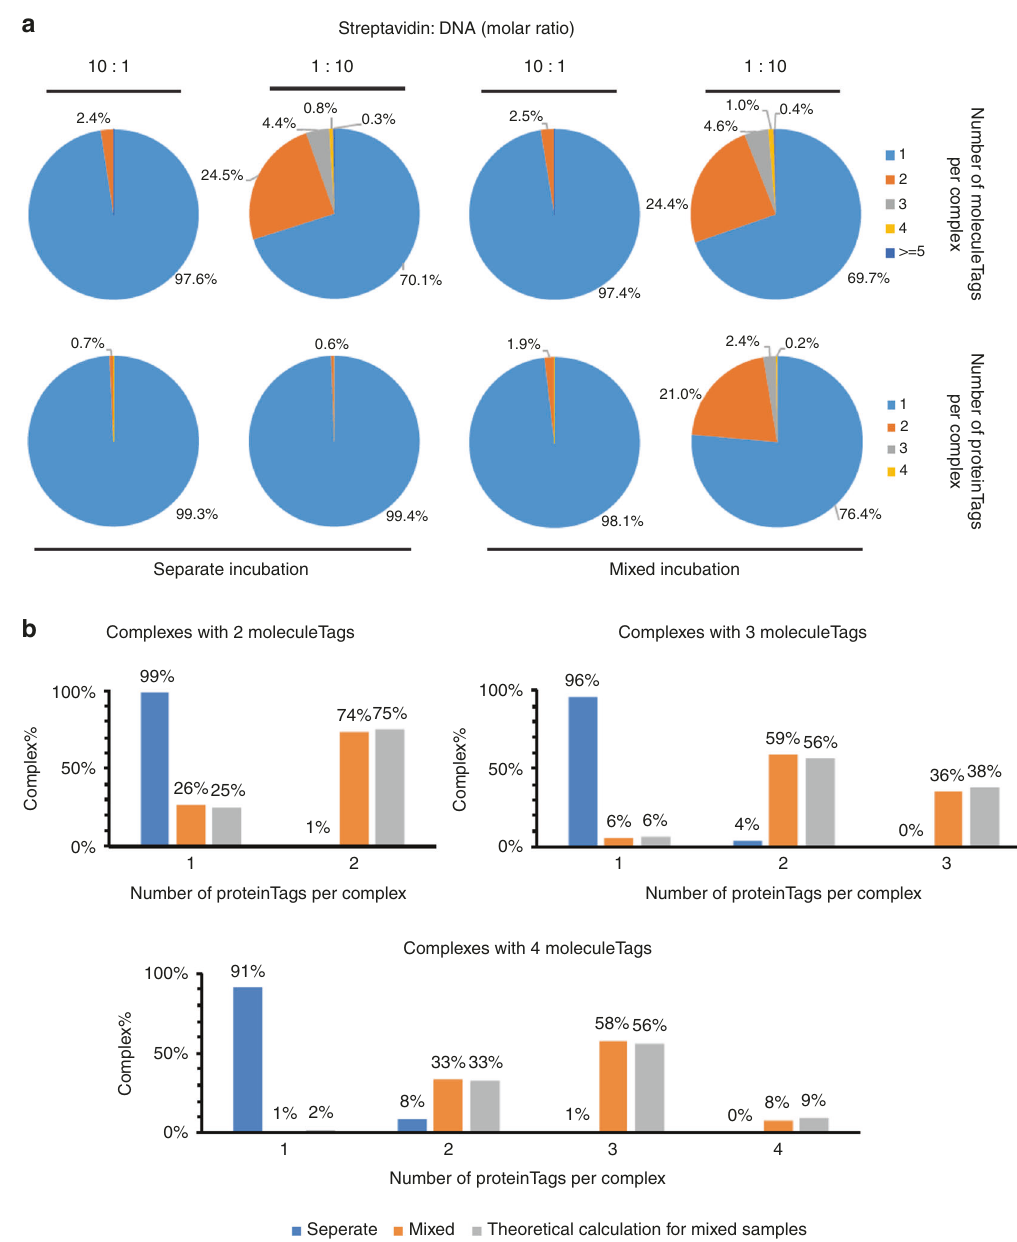
Fig. 2 Validation of PBA using STV-biotin-oligonucleotide complexes. Tetrameric streptavidin molecules were incubated with four different biotinylated oligonucleotides, either separately or in a mixture of all four oligonucleotides. Streptavidin and biotinylated oligonucleotides were combined at molar ratios of 1:10 or 10:1. a The numbers of observed complexes with different numbers of proteinTags and moleculeTags are summarized in pie charts. b When the oligonucleotides were in excess, the numbers of complexes from separate or mixed oligonucleotides incubation with 2, 3, or 4 moleculeTags were grouped according to the number of proteinTags per complex. Theoretical ratios were calculated for the mixed